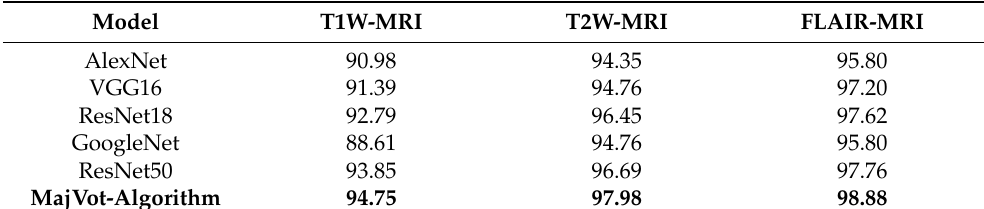
Table 11. The maximum accuracy of six models on three datasets.